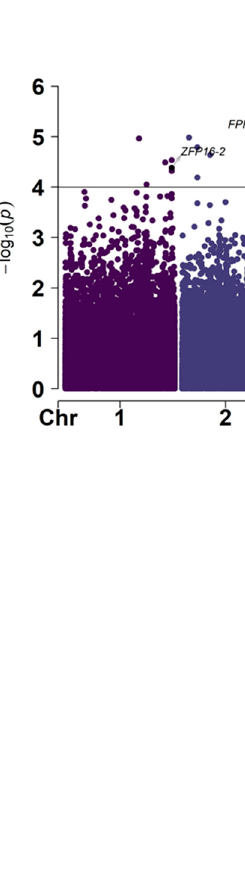
Table 2. Candidate genes for each significant SNP associated with traits and their encoding prod- ucts. Trait